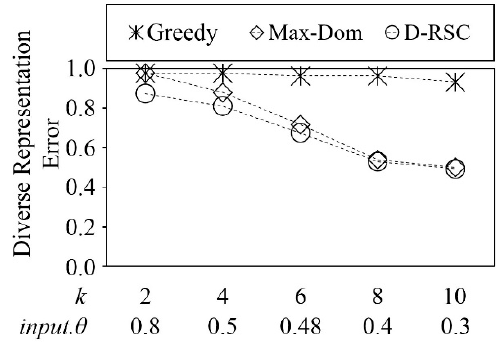
Figure 13. Comparison of diverse representation error on NBA